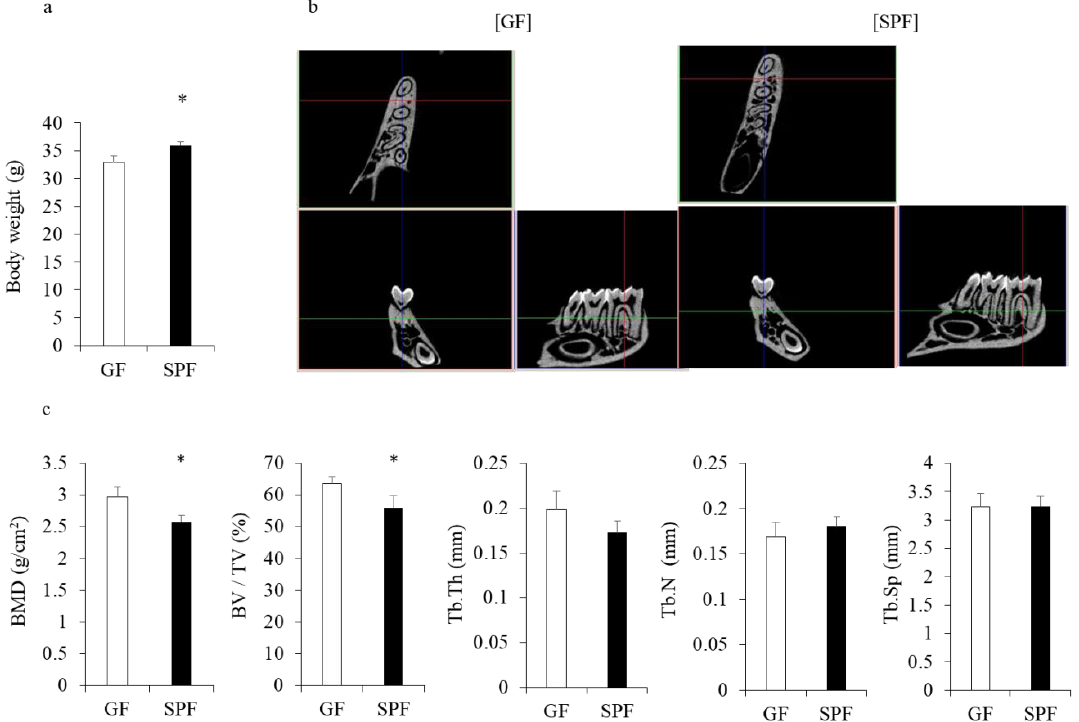
Figure 1. Animal weight and alveolar bone analysis. Eight-week-old male germ-free (GF) and specific pathogen-free (SPF) mice were weighed after isoflurane anesthesia, and then alveolar bones were harvested for micro- micro computed tomography (CT) analysis. ( a ) The weight of SPF mice was significantly greater than that of GF mice. * p < 0.05, t -test ( n = 4/group). ( b ) 3D micro-CT image of root furcation area of the first molar. Left: GF; right: SPF. ( c ) Analysis of micro-CT volumetric parameters: bone mineral density (BMD), bone volume fraction (BV/TV), trabecular thickness (Tb.Th), trabecular number (Th.N), trabecular separation (Tb.Sp). * p < 0.05, t -test ( n = 4/group).